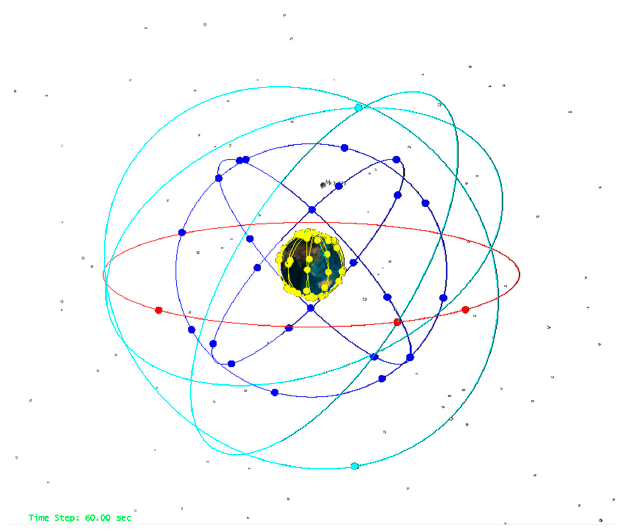
Figure 1. The satellite distribution of the BeiDou-3 and LEO constellation.